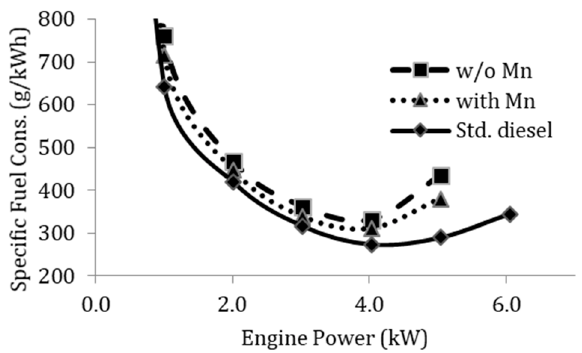
Figure 6. Effect of organic-based Mn additive on specific fuel consumption.